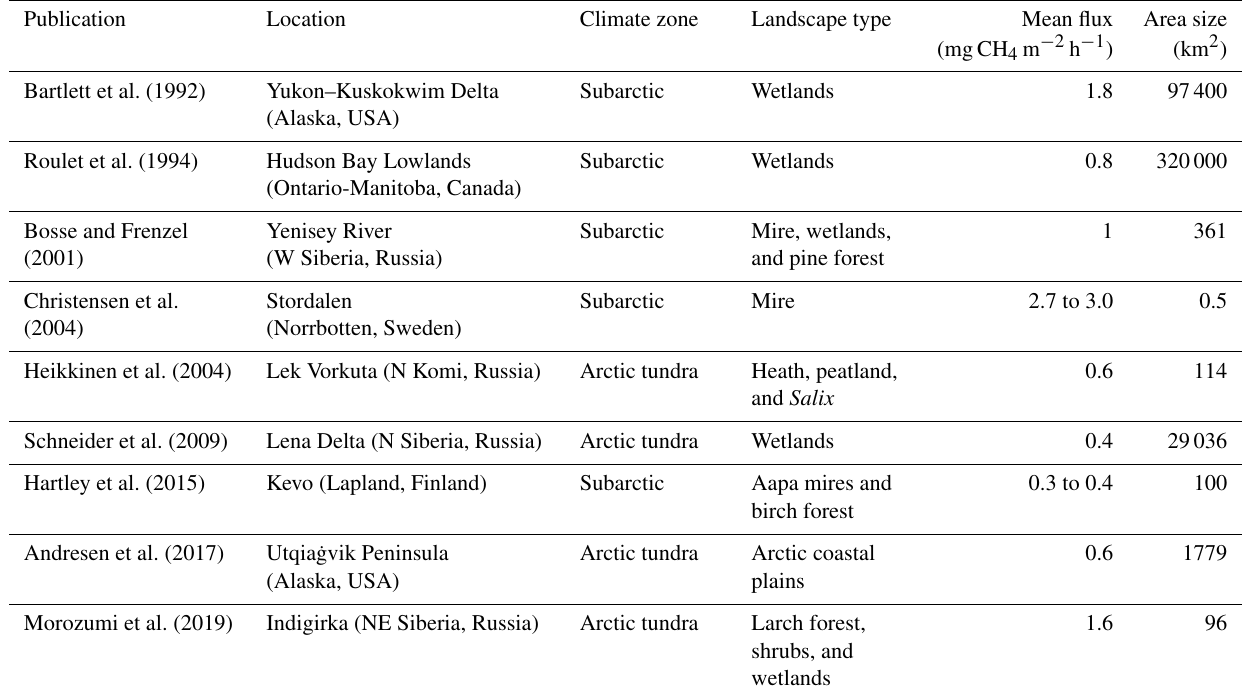
Table 4. Comparison of landscape-integrated growing season methane flux for various subarctic and Arctic sites with a minimum size of 0.5km 2